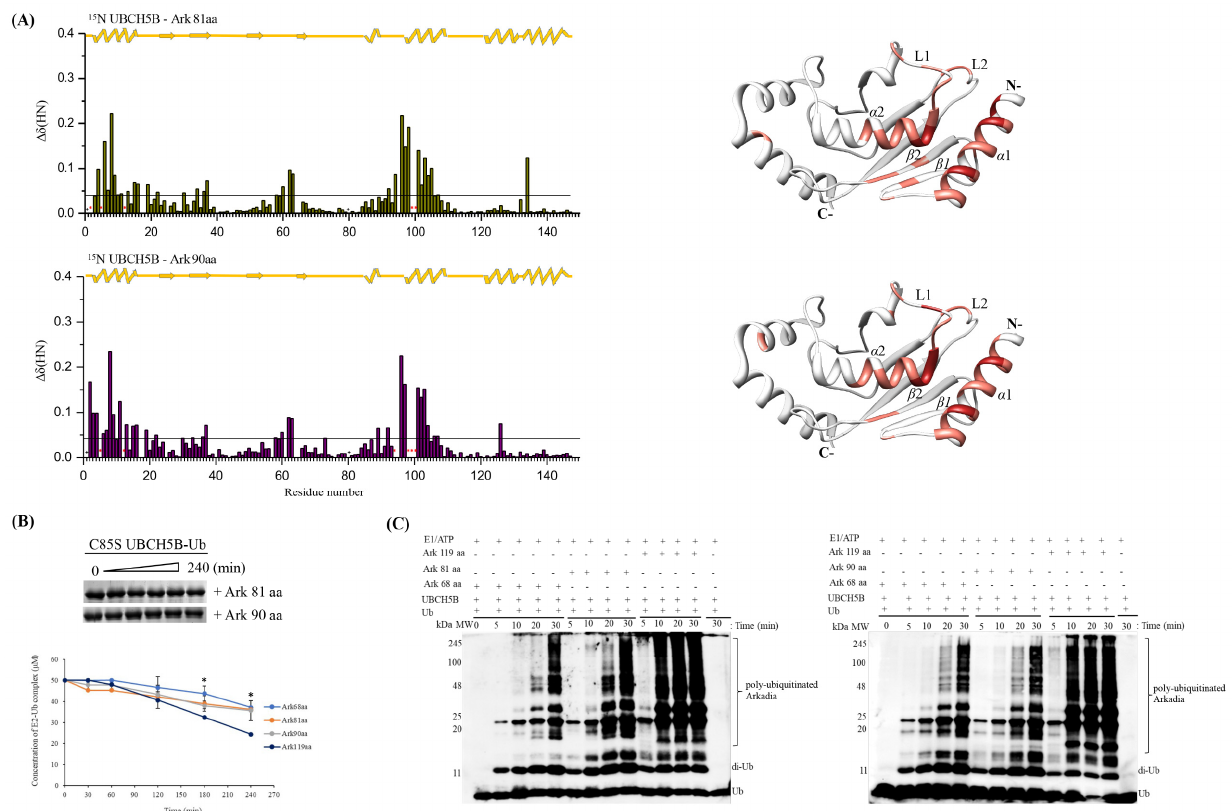
Figure 10. ( A ) Bar graphs of UBCH5B’s CSPs after addition of either Ark 81 aa or Ark 90 aa. *: Represents disappeared residues, +: represents residues with no information. ( B ) Top, oxyester hydrolysis assays showing the disappearance of C85S UBCH5B-Ub in the presence of Ark 68 aa, Ark 81 aa, Ark 90 aa, and Ark 119 aa polypeptides, over time. Bottom, densitometry quantification from gels (bars indicate range of experimental duplicates). * Indicates statistically significant difference ( p value ≤ 0.05). ( C ) In vitro auto-ubiquitination assays of those polypeptides. Control reactions were conducted without addition of Arkadia. All auto-ubiquitination experiments were performed in triplicate.